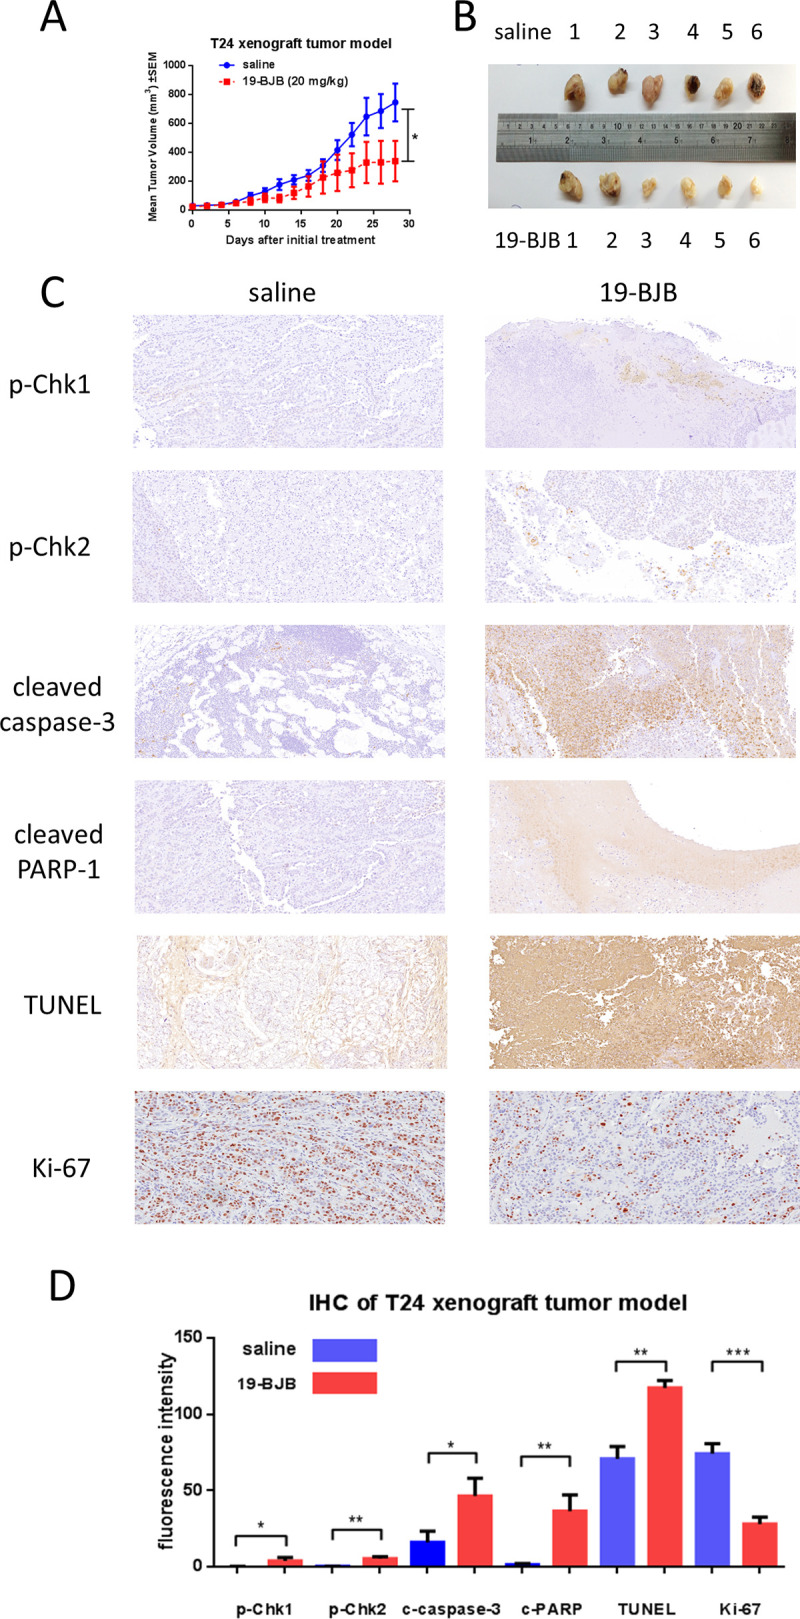
The xenograft tumor model test in nude mice.(A) Tumor volume (mm3) in nude BALB/c mice following s.c. injection of T24 cells, control group and drug group. (B) Tumor photos (control and drug group). (C) Pictures of immunohistochemistry for p-Chk1, p-Chk2, cleaved caspase-3, cleaved PARP-1, TUNEL, Ki-67 respectively. (D) The IHC data was calculated by CaseViewer 2.3. Values represent the mean ± S.E.M. for 3 animals (* p < 0.05, ** p < 0.01, mean ± S.E.M.).